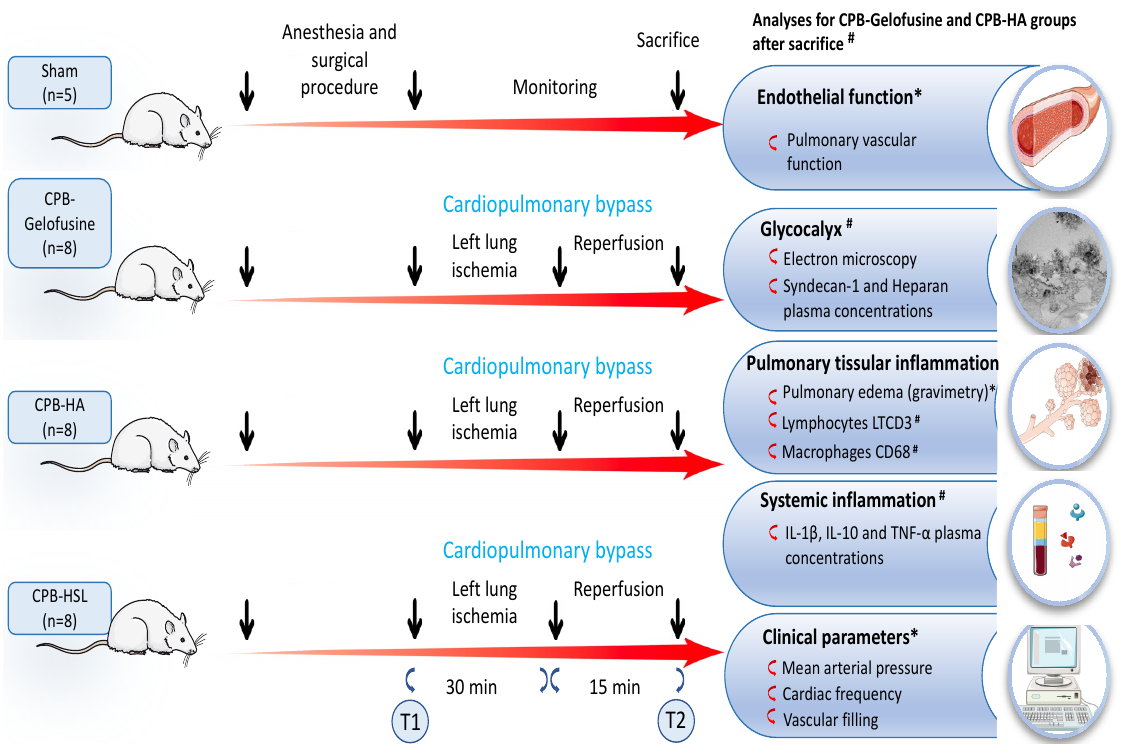
Figure 6. Schematic diagram of the experimental procedure and sampling points. T1, Time 1 corresponding to left lung IR with CPB and samples obtained at the end of anesthesia-surgical procedure. T2, Time 2 corresponding to samples obtained at the end of the experiment. Abbreviations: CPB, cardiopulmonary bypass; IR, left lung ischemia–reperfusion; HA, human albumin; HSL, hypertonic sodium lactate. * Analyses for all groups after sacrifice. # Analyses for CPB-Gelofusine and CPB-HA groups after sacrifice.